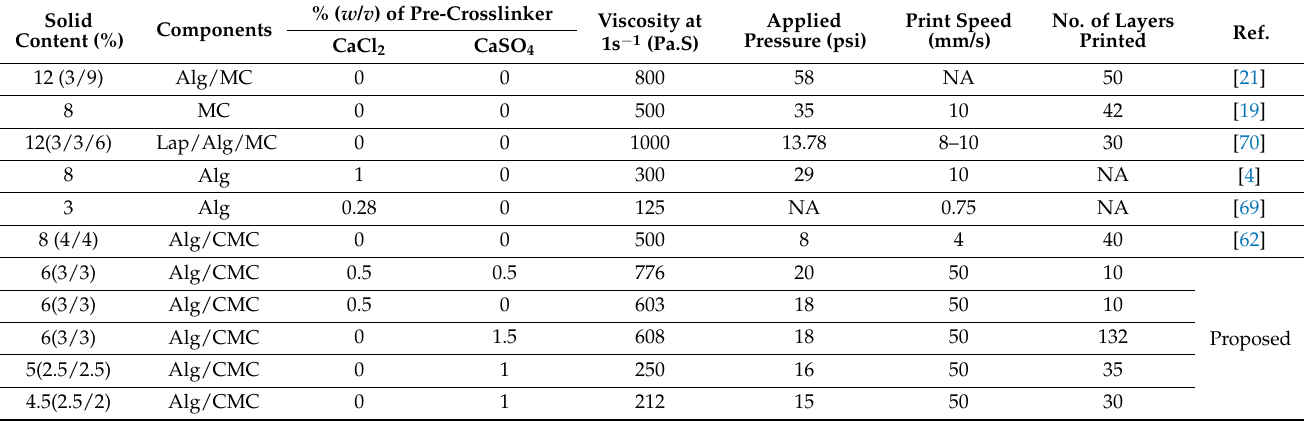
Table 6. Comparison between proposed and various existing hybrid hydrogels in terms of solid content, pre-crosslinker percentage and subsequent viscosity, applied pressure, and the number of layers